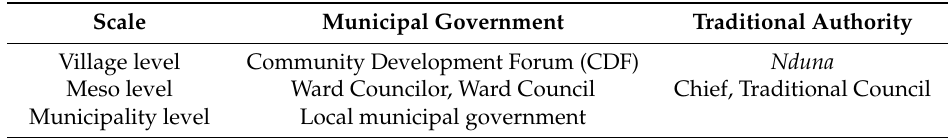
Table 1. Institutions operating at various spatial scales across the Bushbuckridge study